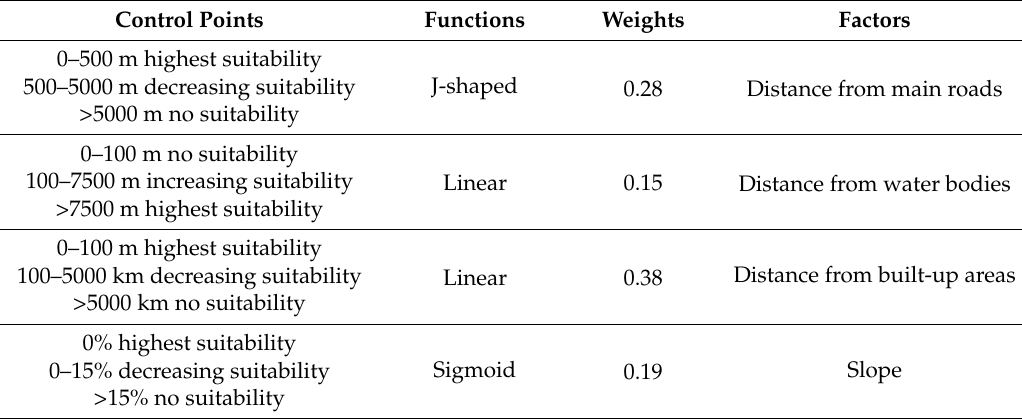
Table 3. Extracted weights based on analytic hierarchy process (AHP) and fuzzy standardization for urban areas.